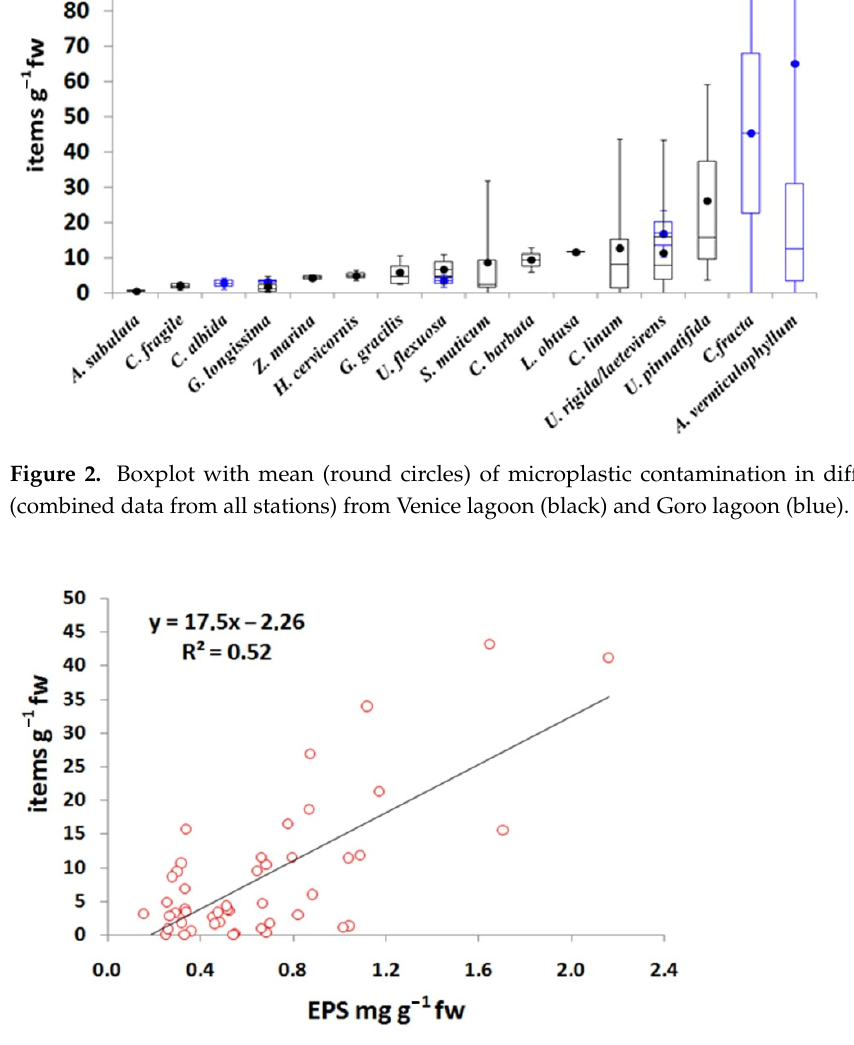
Figure 3. Plot of macrophyte EPS contents vs relative microplastic contents.